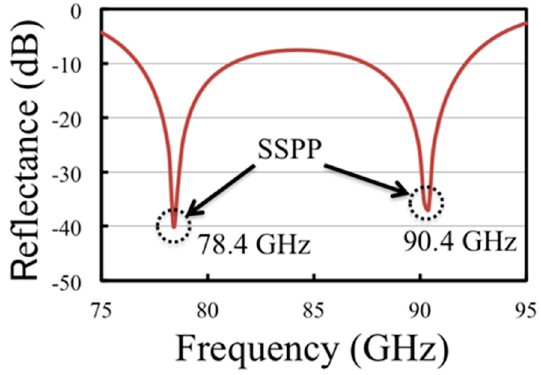
Figure 6. The frequency dependence of the reflectance of the MHA.